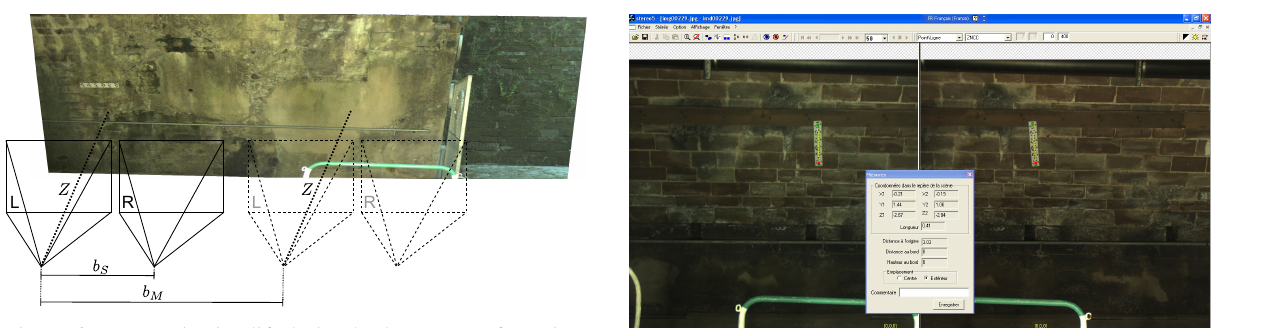
Figure 6: Automatic simplified visual odometry configuration. Solid lines: stereo rig at time t . Dashed lines: stereo rig at times t − 1 . The cameras are supposed to be parallel to the side wall. Figure 7: Example of measurement on a side wall using a stereo pair. The real distance between points on the bar-coded target is 42 cm. The measured distance is 41